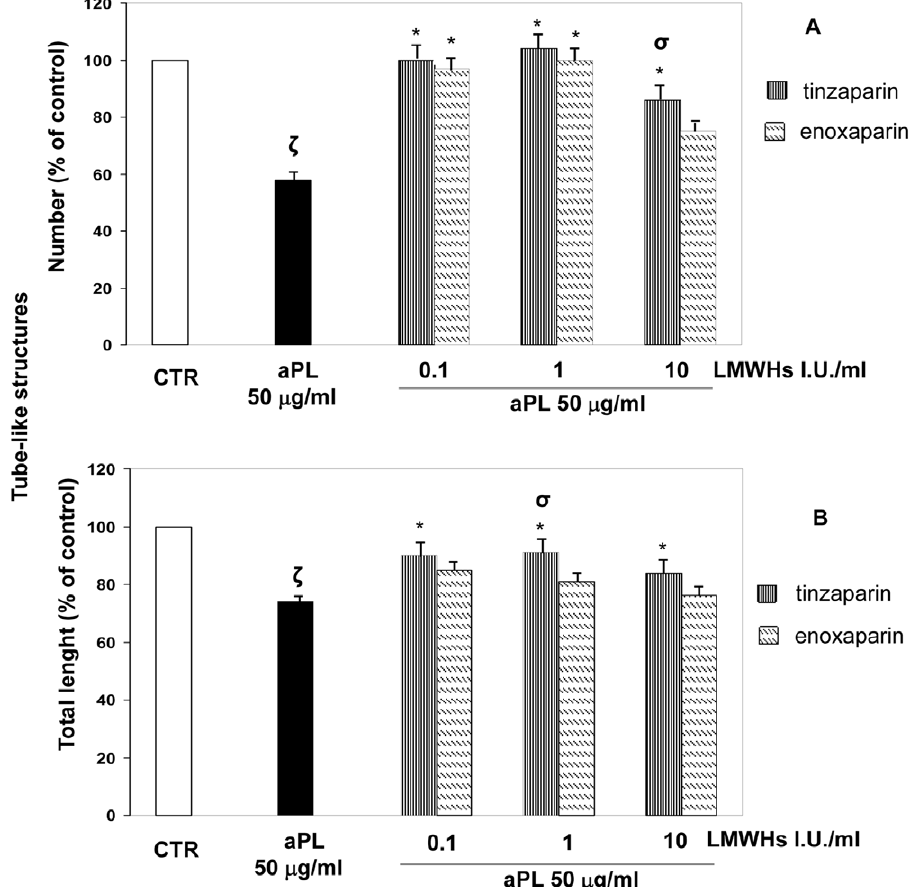
Figure 2. Invitro angiogenesis assay. To evaluate the effects of tinzaparin or enoxaparin on aPL-inhibited angiogenesis we used an in vitro assay of human endometrial endothelial cells (HEEC) capable of forming tube-like structures in response to the extracellular matrix protein, Matrigel, in endothelial cell culture medium (EBM-2) MV Single Quots. Cells were seeded in matrigel coated plates and examined for tube formation microscopically. The figure shows the quantitative analysis of number (A) and total length (B) of tube-like structures after treatment with aPL (50 m g/ ml) with or without tinzaparin or enoxaparin (0.1–10 IU/ml). Results are means 6 SE of five experiments and expressed as % of control (CTR=100). (CTR: untreated cells; f : P , 0.05 compared with CTR; *: P , 0.05 compared with aPL; s : P , 0.05 enoxaparin vs